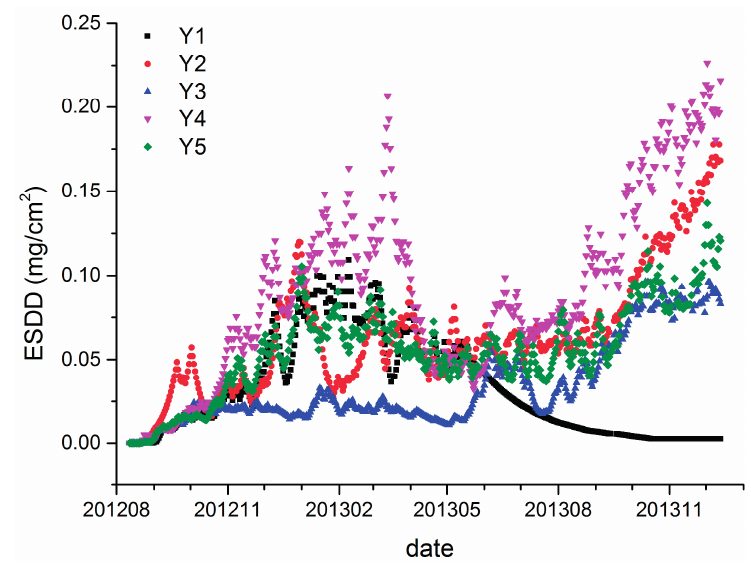
Figure 5. On-line measurements of five sites in Yichang.